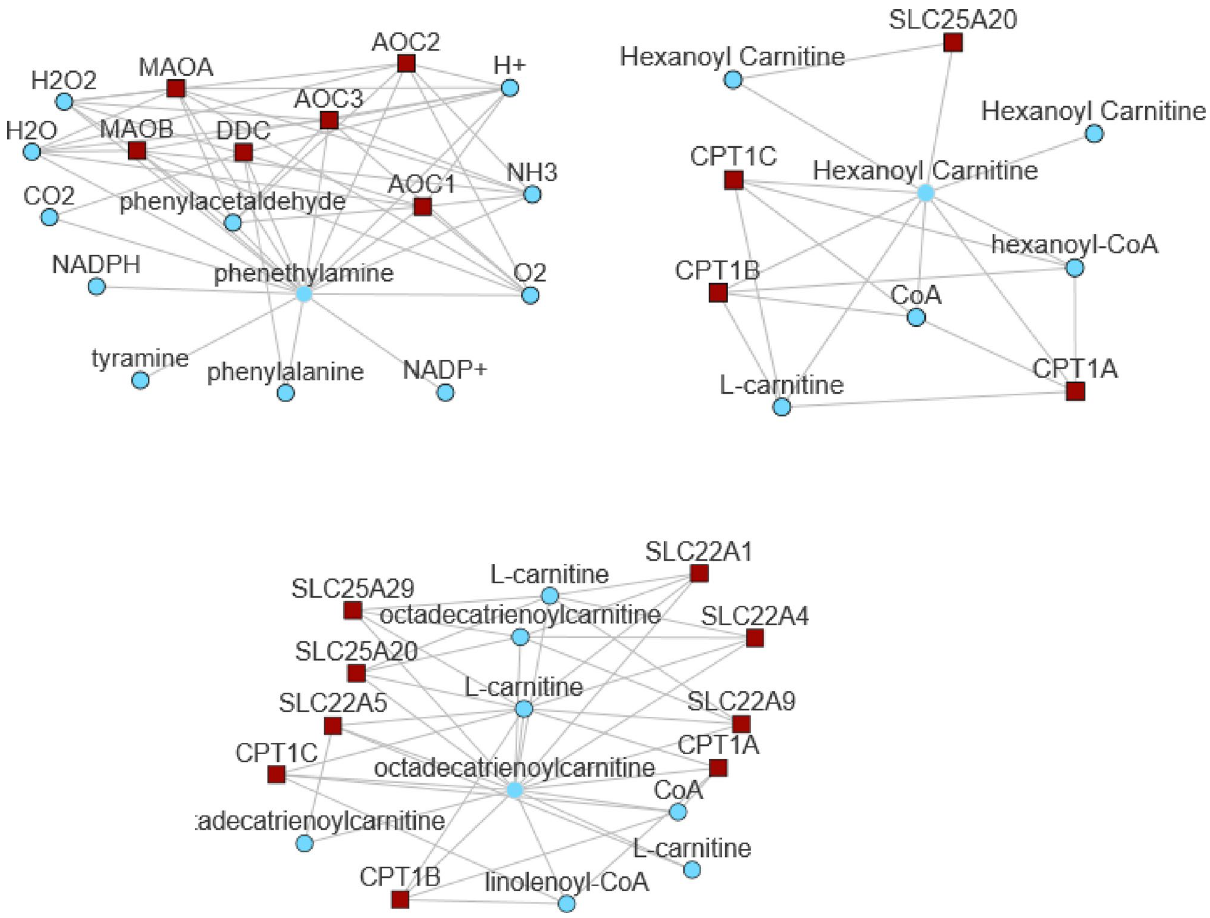
based on the metabolic network 37 . Figure is obtained from metabolicatlas.org 37